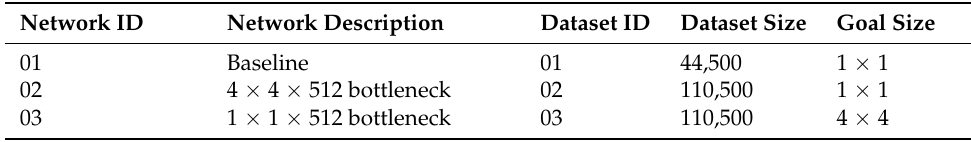
Table 1. Labeling conventions for the experiments.